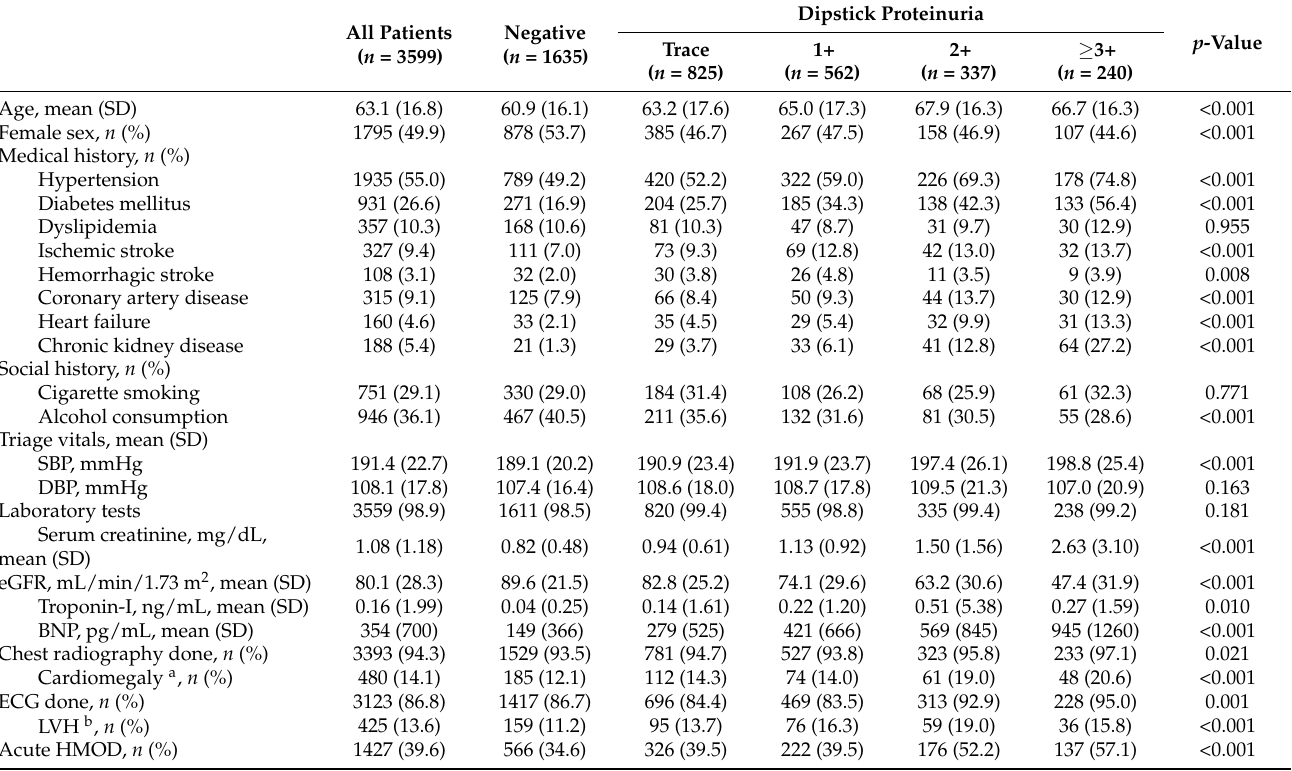
Table 1. Baseline